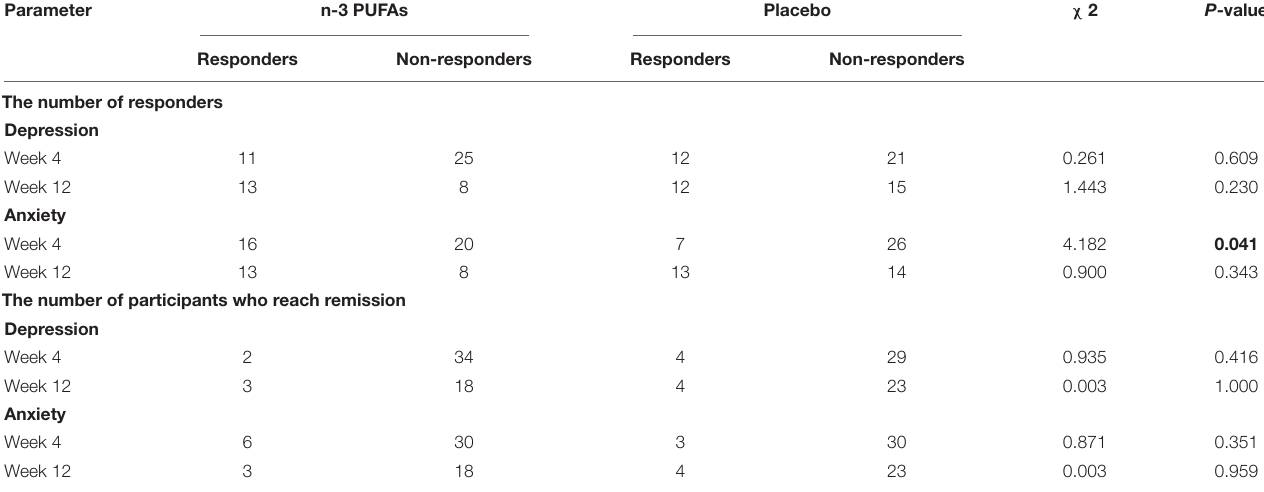
TABLE 3 | The number of responders and the full remission in n-3 PUFAs and placebo group. Parameter n-3 PUFAs Placebo χ 2 P -value Responders